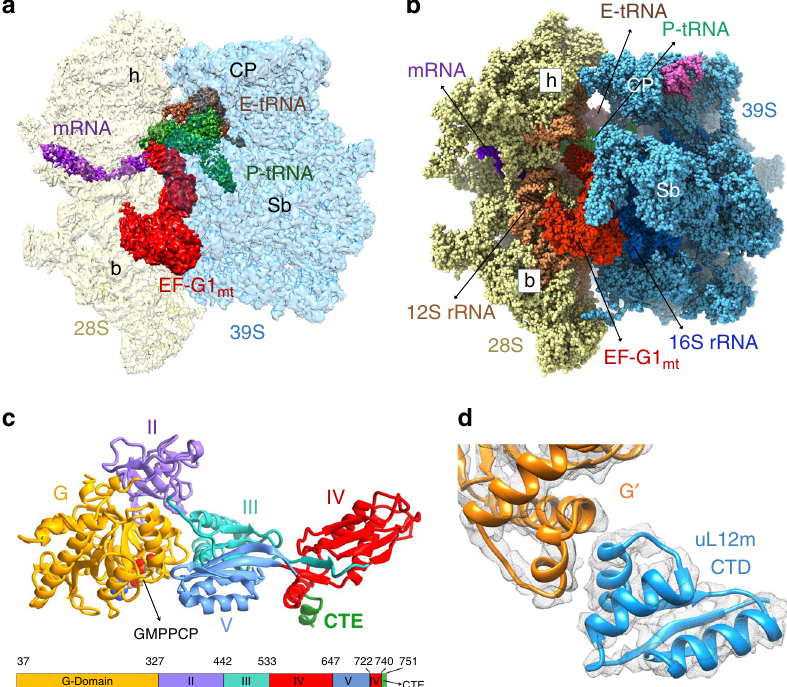
Fig. 1 Cryo-EM structure of the human mitochondrial 55S·EF-G1 mt ·GMPPCP Class III complex. a Segmented cryo-EM densities, showing 28S (semitransparent yellow), 39S (semitransparent blue), EF-G1 mt (red), P-site tRNA mt (green), fragmented E-site tRNA mt (brown), and small segment of mRNA (purple), as viewed from the subunit-subunit interface side. b Atomic model of components within the complex, colored as in panel a . Landmarks on the 28S subunit: h head, b body. Landmarks on the 39S subunit: CP central protuberance, Sb uL11m stalk base. c Structure of EF-G1 mt displaying its fi ve domains and the bound GMPPCP molecule, with a color-coded bar diagram depicting domain organization of EF-G1 mt . d Interaction between the C-terminal domain (CTD, blue) of uL12m and G ′ subdomain (orange) of EF-G1 mt